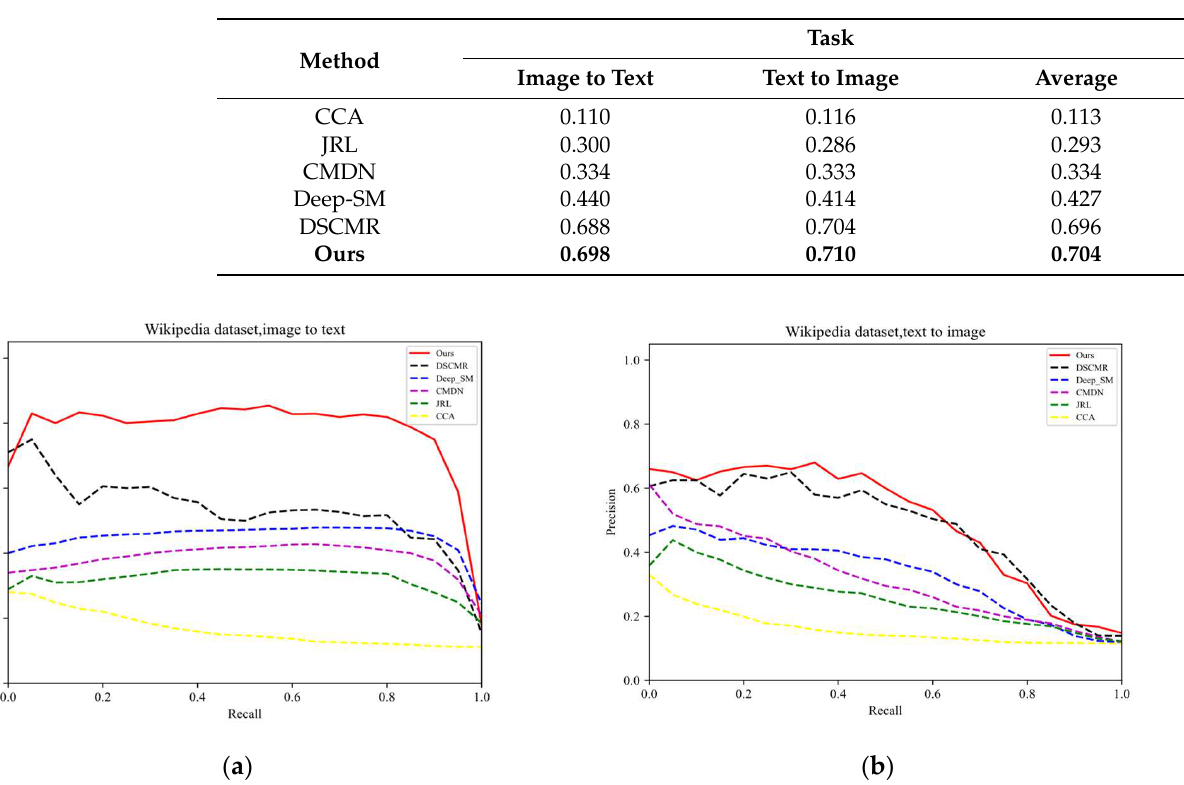
( b ) Figure 10. The PR curves of the cross-modal retrieval performance on the Pascal Sentence dataset. ( a ) The image to text task on the Pascal Sentence dataset. ( b ) The text to image task on the Pascal Sentence dataset.